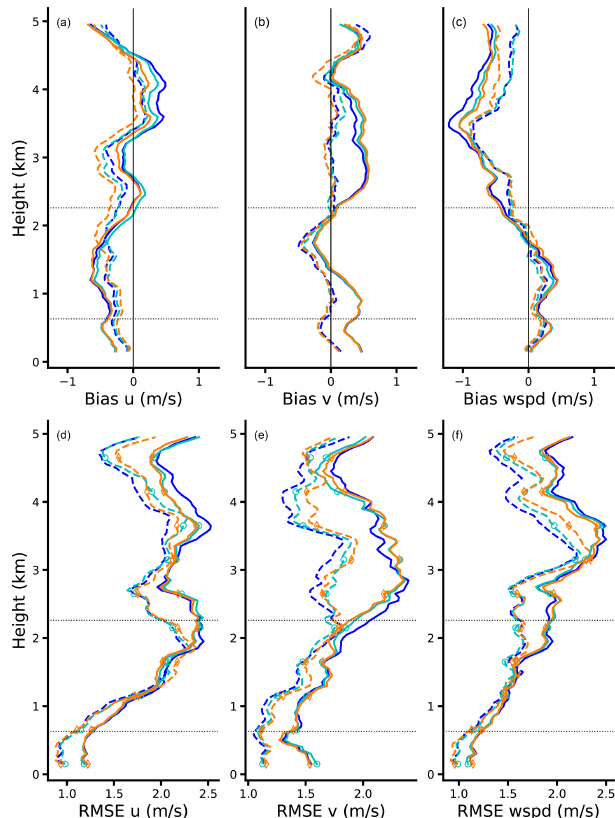
Figure 9. Monthly mean IFS bias (a–c) and root mean square er- ror (d–f) against radiosondes as in Fig. 5d–i; forecasts are in solid and analyses in dashed. In the control experiment (blue) both drop- sondes and radiosondes from EUREC 4 A are assimilated. In the first experiment (cyan) dropsondes are excluded from the assimilation. In the second experiment (orange) neither dropsondes nor radioson- des are